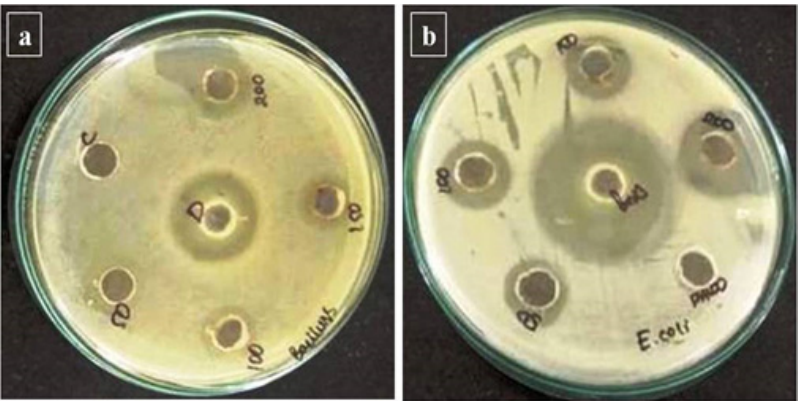
Figure 5. The green synthesized LC Y 2 O 3 NPs showed an improved zone of inhibition against ( a ) Bacillus , and ( b ) E. coli , compared to Y 2 O 3 NPs.